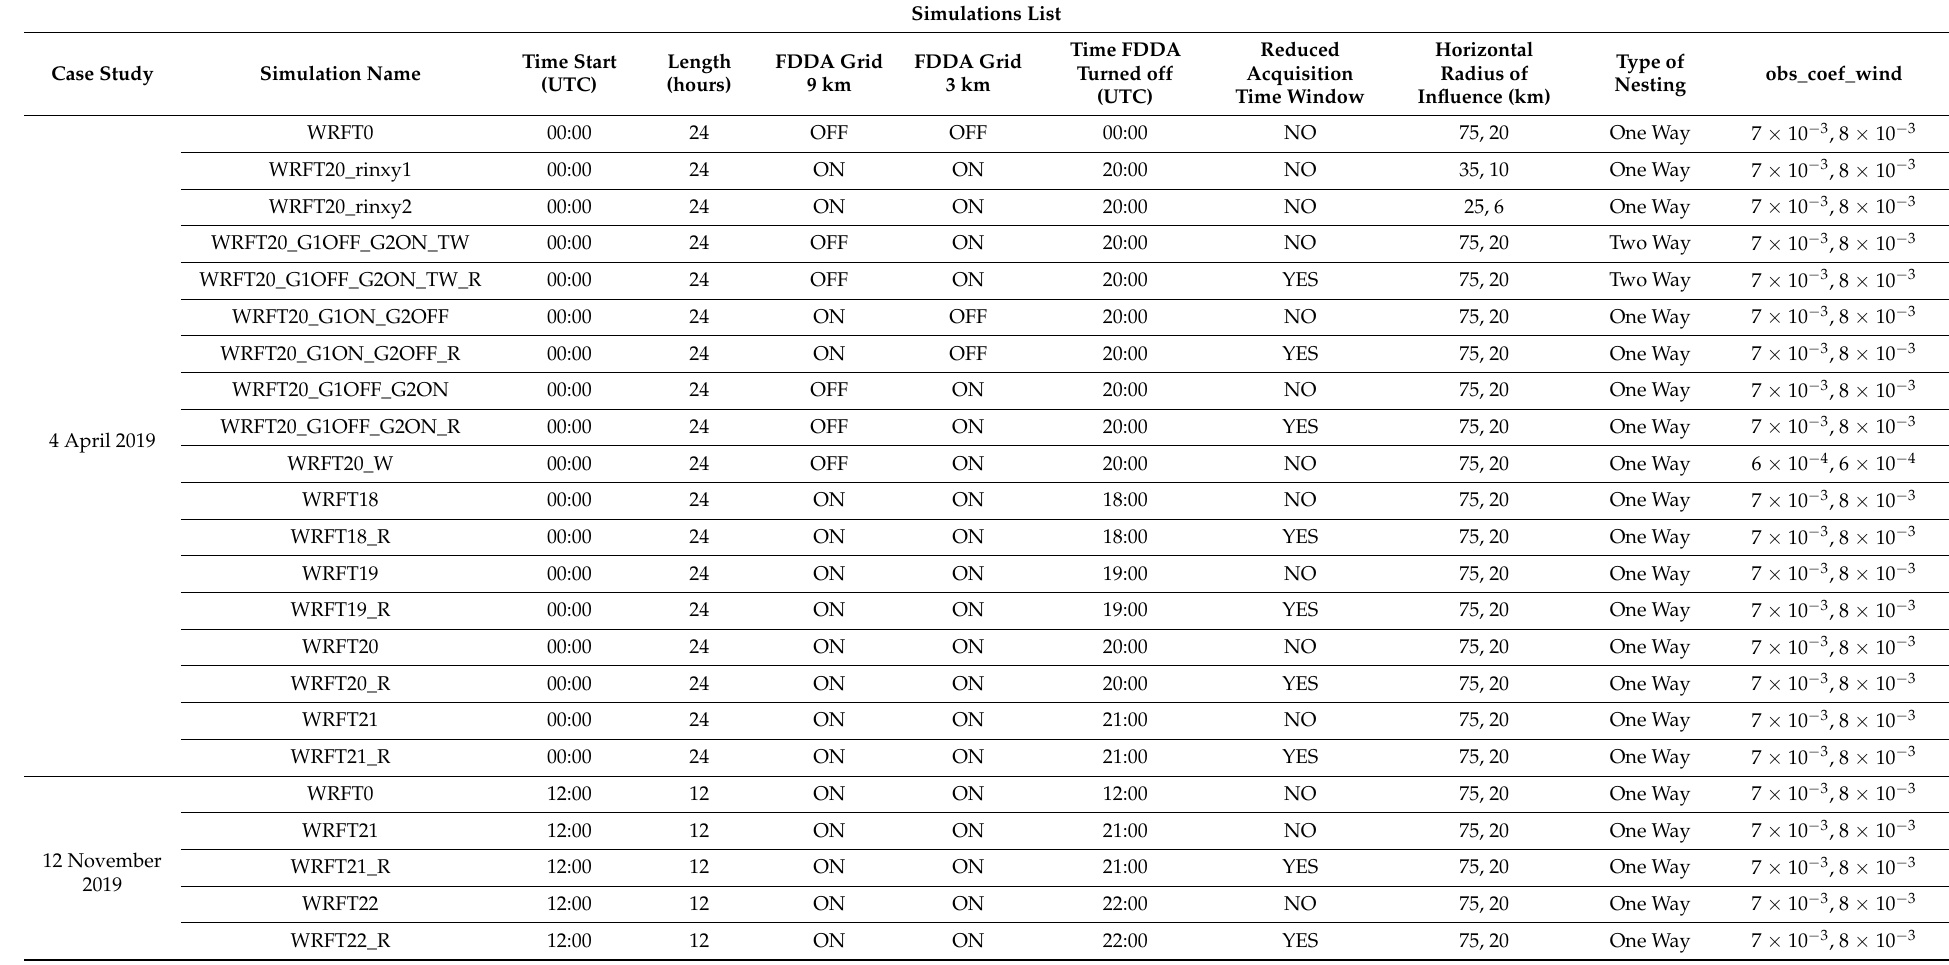
Table 2. List of